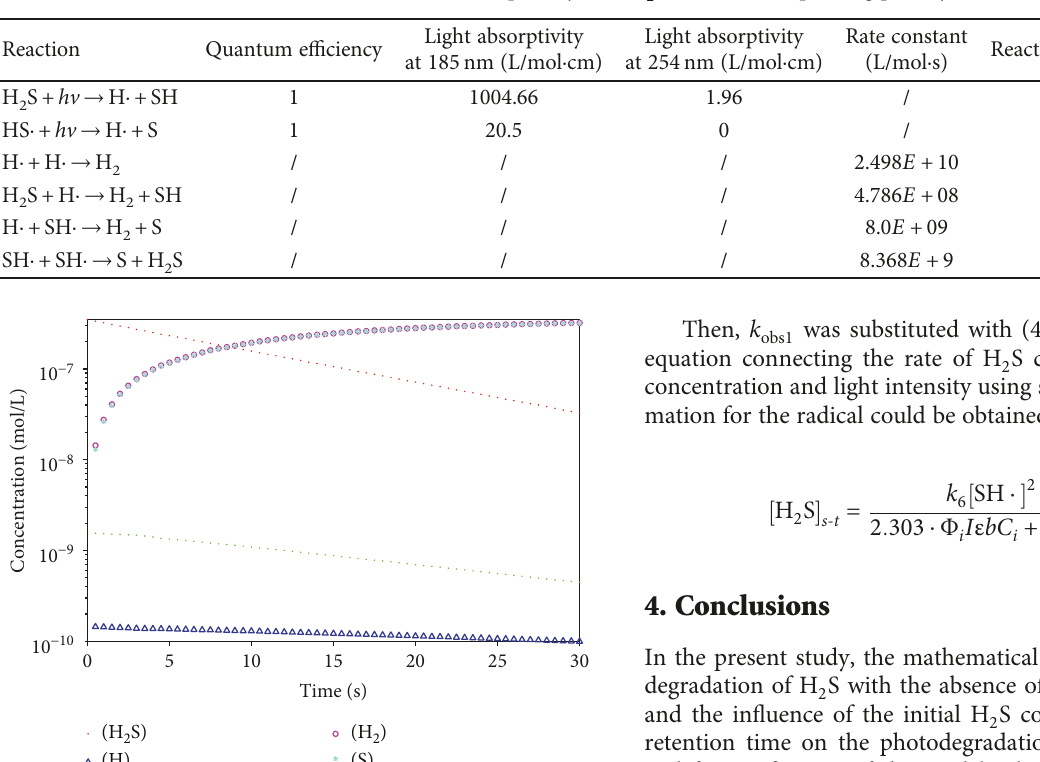
Table 1: The chemical reaction of direct photolysis of H